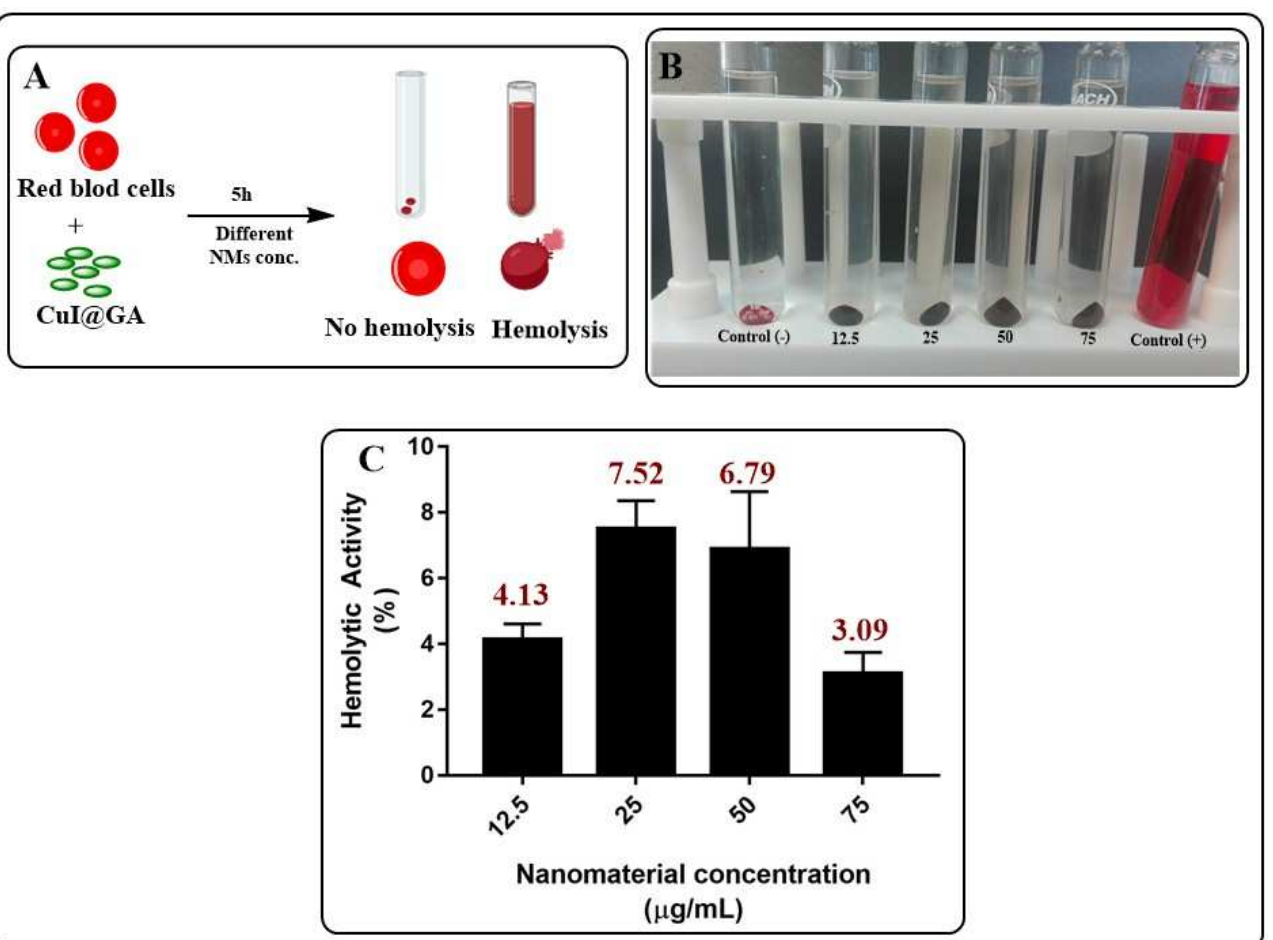
Figure 11. Evaluation of the hemolitic activity of CuI@AG. ( A ) Schematic representation of the interaction of red blood cells and CuI@AG. ( B , C ) Qualitative and quantitative evaluation of the hemolitic activity of CuI@AG at different